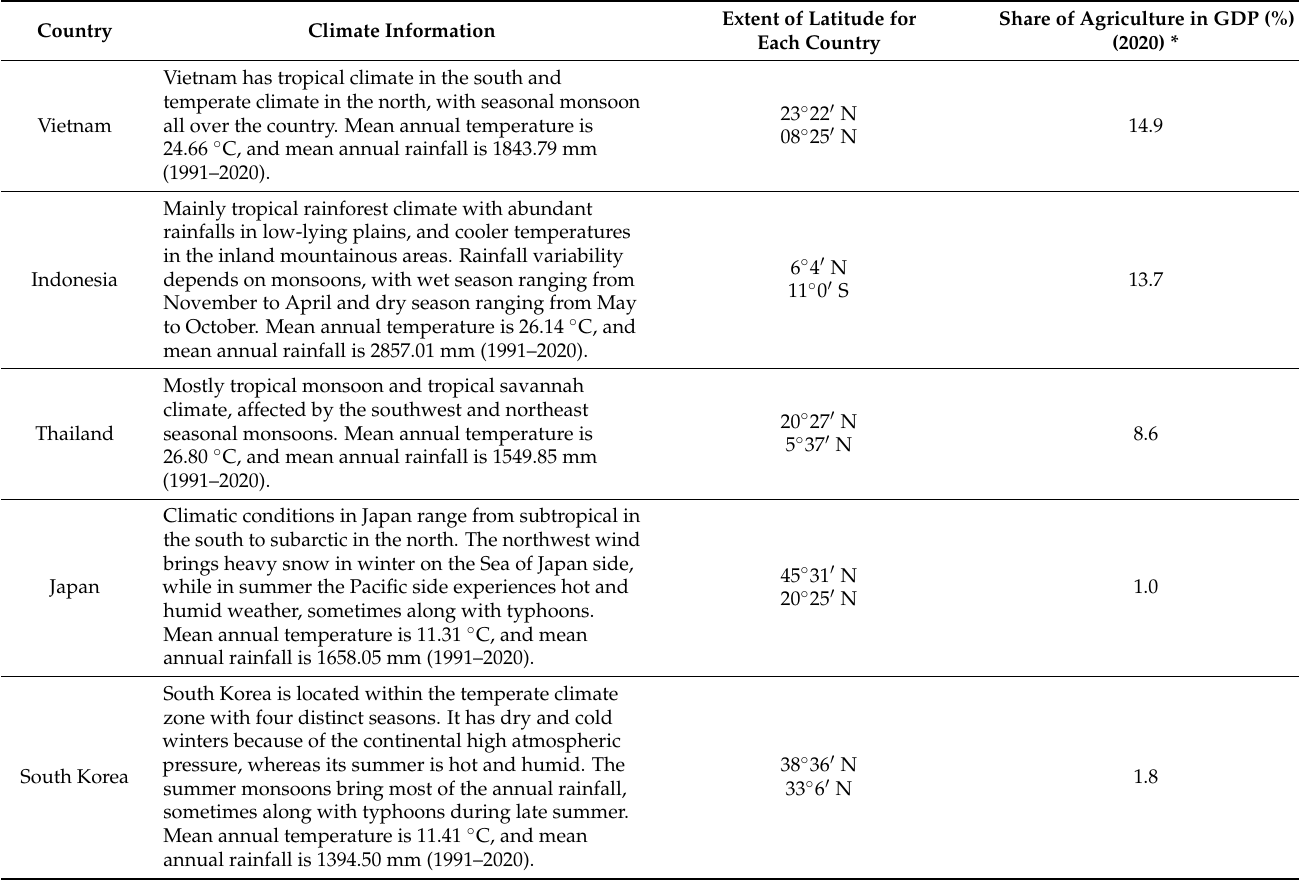
Table 10. Geographic and climatic information of Vietnam, Indonesia, Thailand, Japan, and South Korea. (Source: data retrieved from